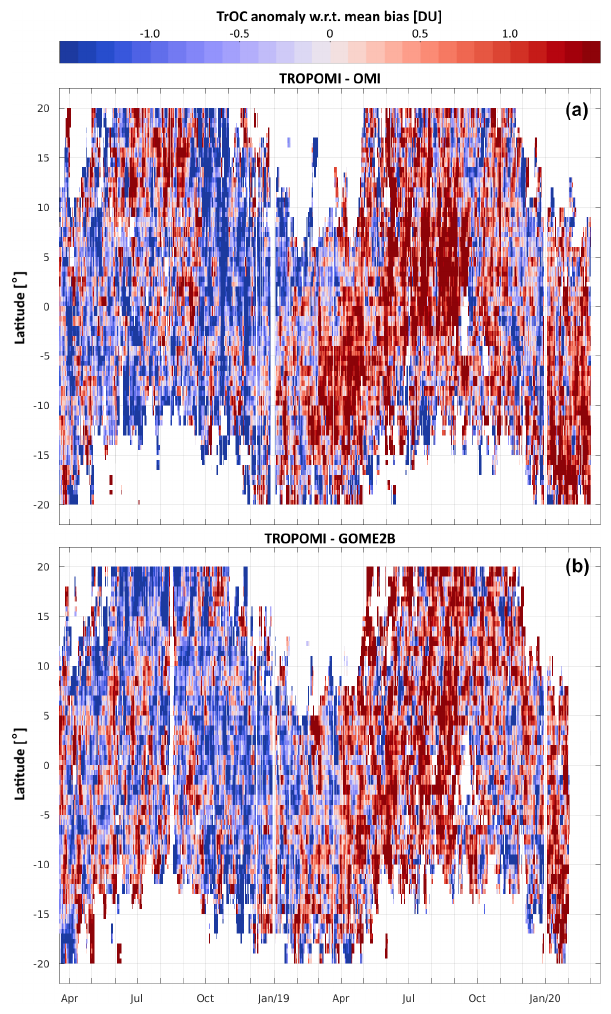
Figure 3. Latitude–time section of the anomaly of the TROPOMI tropospheric ozone column with respect to its mean bias with OMI (a) and GOME-2B (b) from April 2018 through February 2020. Zonal mean differences of the bias have been subtracted in order to better highlight the meridian coherence of the change over